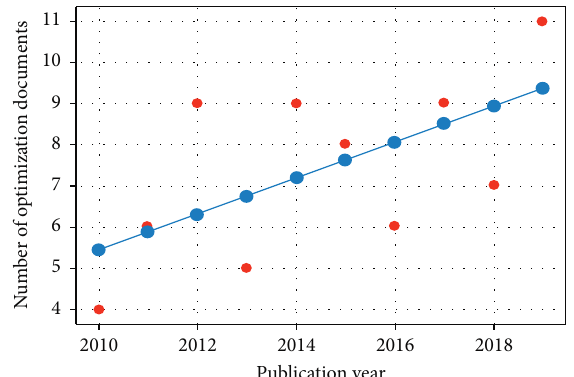
Figure 12: The regression line for optimization publications during